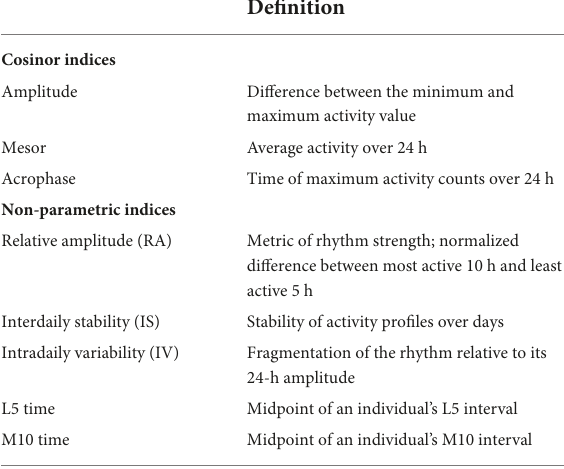
TABLE 1 Definitions of circadian rest activity rhythm (CRAR)